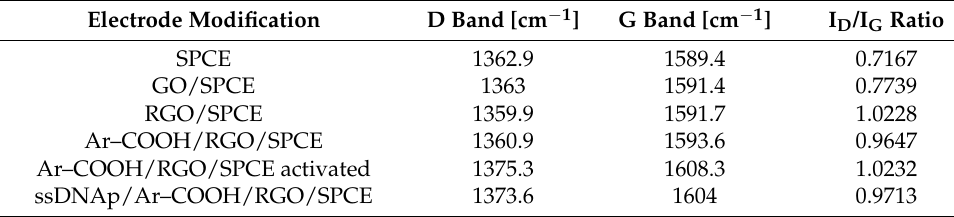
Figure 2. Raman spectra of bare SPCE ( a ), GO/SPCE ( b ), RGO/SCPE ( c ), Ar–COOH/RGO/SPCE ( d ), Ar–COOH/RGO/SPCE activated in EDC–NHS ( e ), and ssDNAp/Ar–COOH/RGO/SPCE ( f ). Table 1. Positions of D and G bands and their I D /I G ratio from Raman spectra.